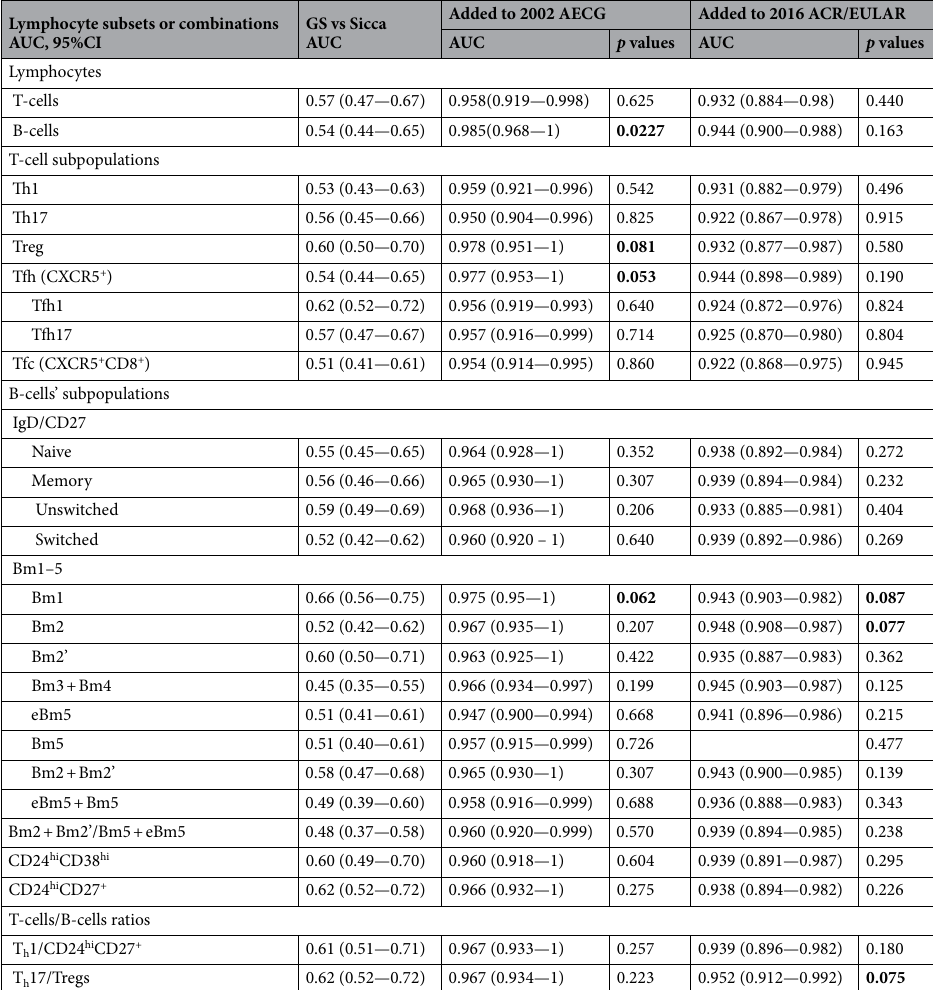
Table 3. Area Under the Curve (AUC) receiver operating characteristic curve (ROC) of the comparison of T and B-cell subsets percentages in SjS (clinical diagnosis) and Sicca groups (GS vs Sicca). Added-value of the addition of each cell subset to the AECG (AUC and p-value) and the ACR/EULAR criteria (AUC and p-value). Bold numbers represent significance (p-values < 0.05) or relevance (p-values < 0.100). GS, Gold-Standard; AUC, area under the Receiver-Operating-Characteristic Curve; IC: Interval of Confidence, AECG, American- European Consensus Group classification criteria; ACR/EULAR, American College of Rheumatology/ European League Against Rheumatism classification